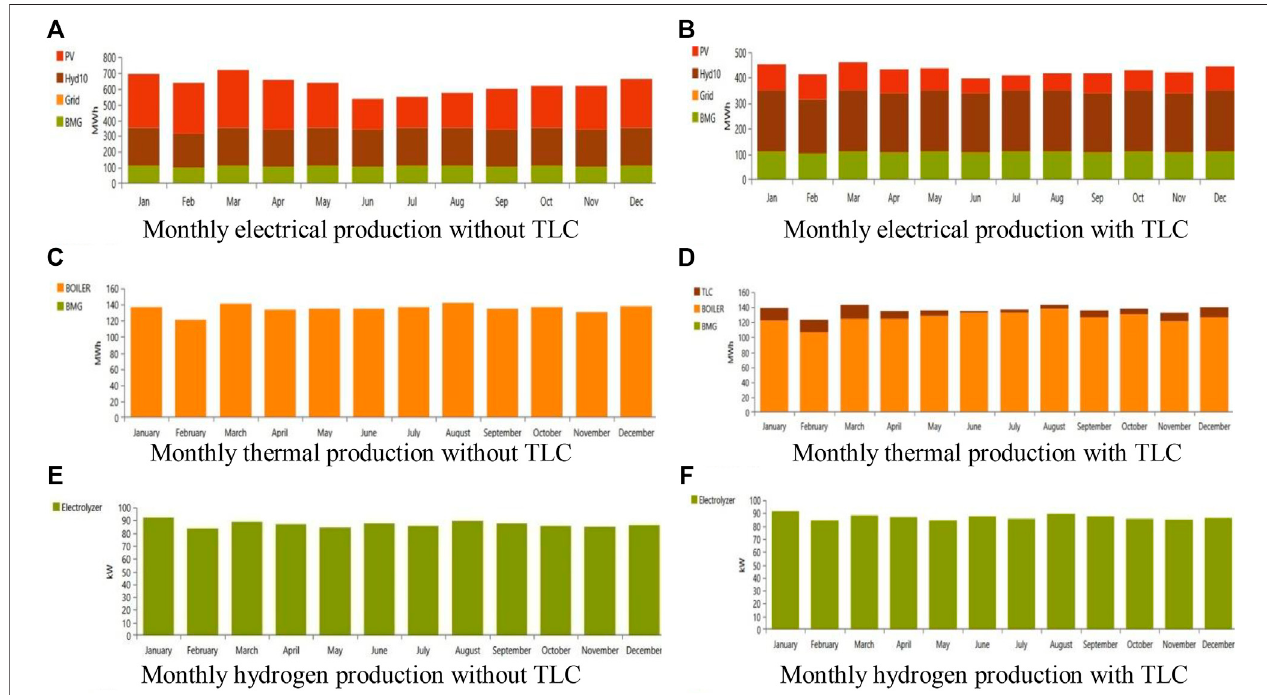
FIGURE15| Monthlyenergyproductions,transactions,andcharges. (A) MonthlyelectricalproductionwithoutTLC. (B) MonthlyelectricalproductionwithTLC. (C) MonthlythermalproductionwithoutTLC. (D) MonthlythermalproductionwithTLC. (E) MonthlyhydrogenproductionwithoutTLC. (F) Monthlyhydrogenproductionwith TLC. (G) Monthly electrical production withTLC and 50% CHP. (H) Monthly thermal production with TLC and 50%CHP. (i) Monthly hydrogen production with TLC and 50% CHP. (J) Monthly electrical transactions. (K) Monthly electricity charges.